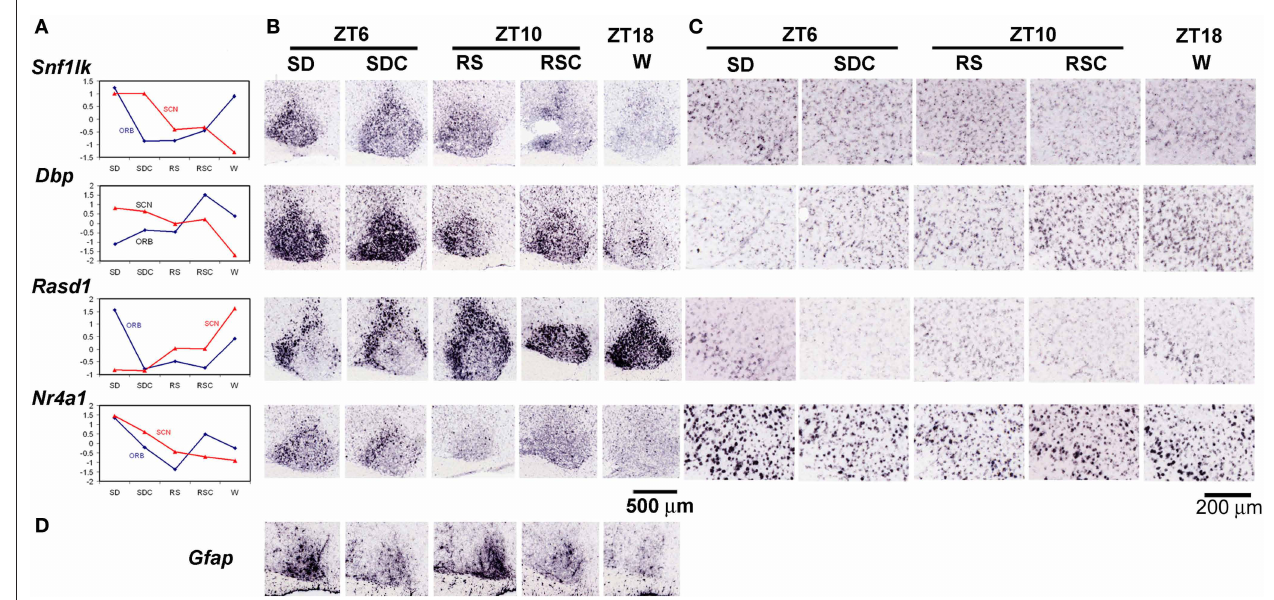
and orbital cortex (C) across five behavioral conditions for the four genes shown in (A) . (D) Induction of Gfap in the SCN by SD. Labels across the top indicate the circadian time (ZT6, 10, or 18) and whether there was an experimental manipulation (SD or RS). Scale bar in (B) : 500 μm. Scale bar in (C) : 200